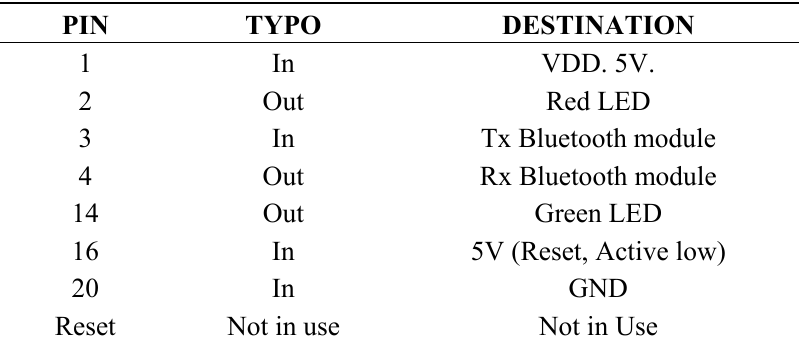
Table 1. Pinout of